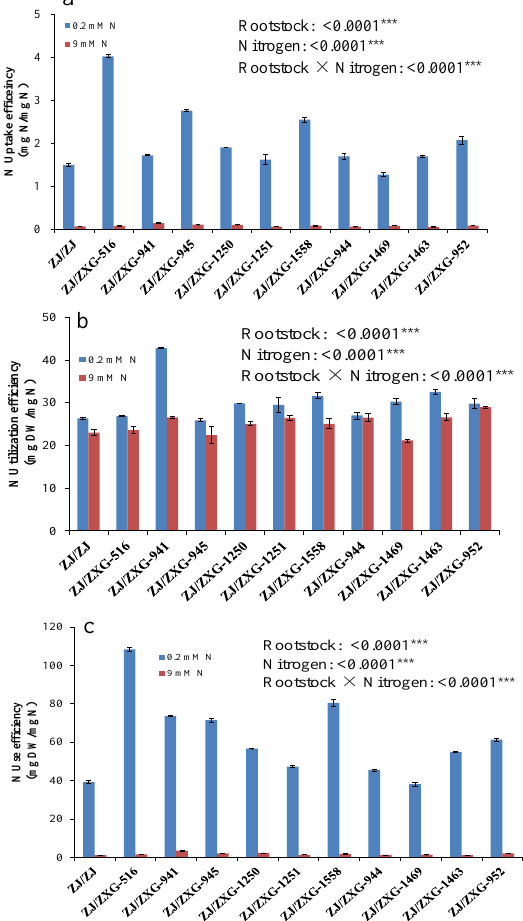
Figure 3. N uptake efficiency ( a ), N utilization efficiency ( b ), and N use efficiency ( c ) of watermelon cultivar Zaojia 8424 (ZJ), self-grafted (ZJ/ZJ) and grafted onto 10 different wild watermelon rootstocks under normal (9 mM) and low (0.2 mM) N conditions. Values are means ± SE of three replicates. *** represent P ≤ 0.05.